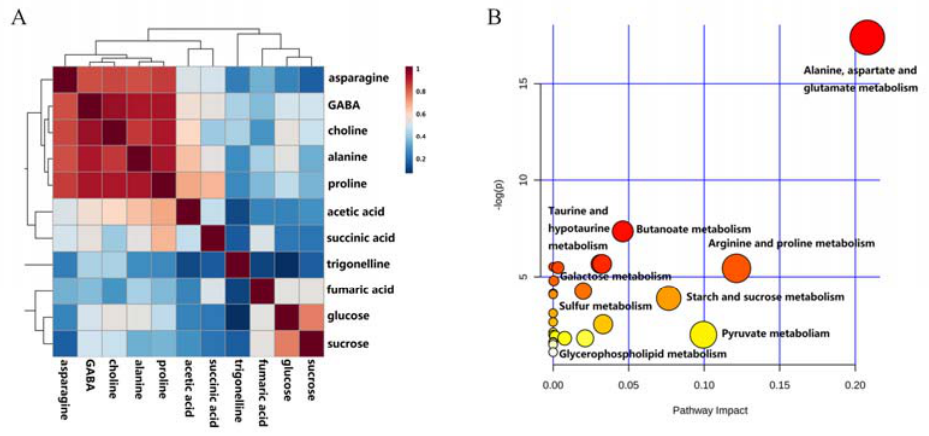
Figure 5. Cont . Figure 5.